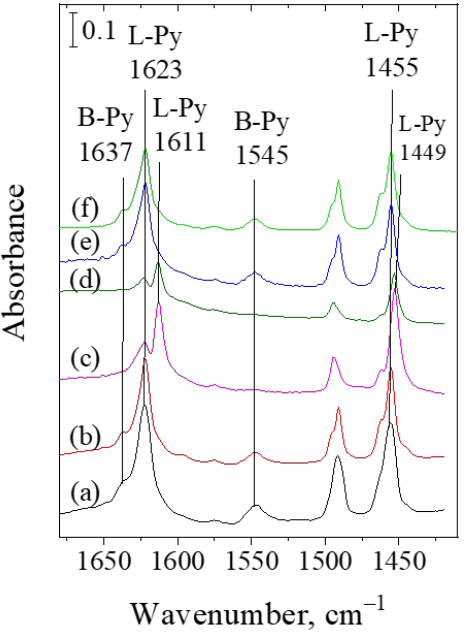
Figure 8. FT-IR spectra of adsorbed pyridine on the studied catalysts: ( a ) parent zeolite Beta, ( b ) 1Pt/HB, ( c ) 10Ni/HB, ( d ) 10Ni1Pt/HB, ( e ) 5Ru/HB, ( f ) 5Ru1Pt/HB. Py (6 mbar) was adsorbed on 400 °C dehydrated samples at 200 °C and desorbed at 400 °C in high vacuum.